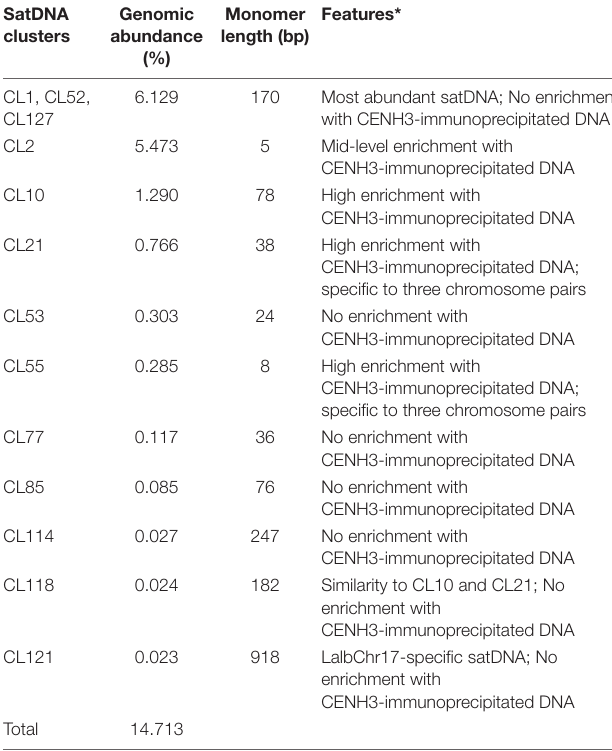
TABLE 1 | Satellite DNA diversity in white lupin: genomic abundance, monomer length, and features. SatDNA